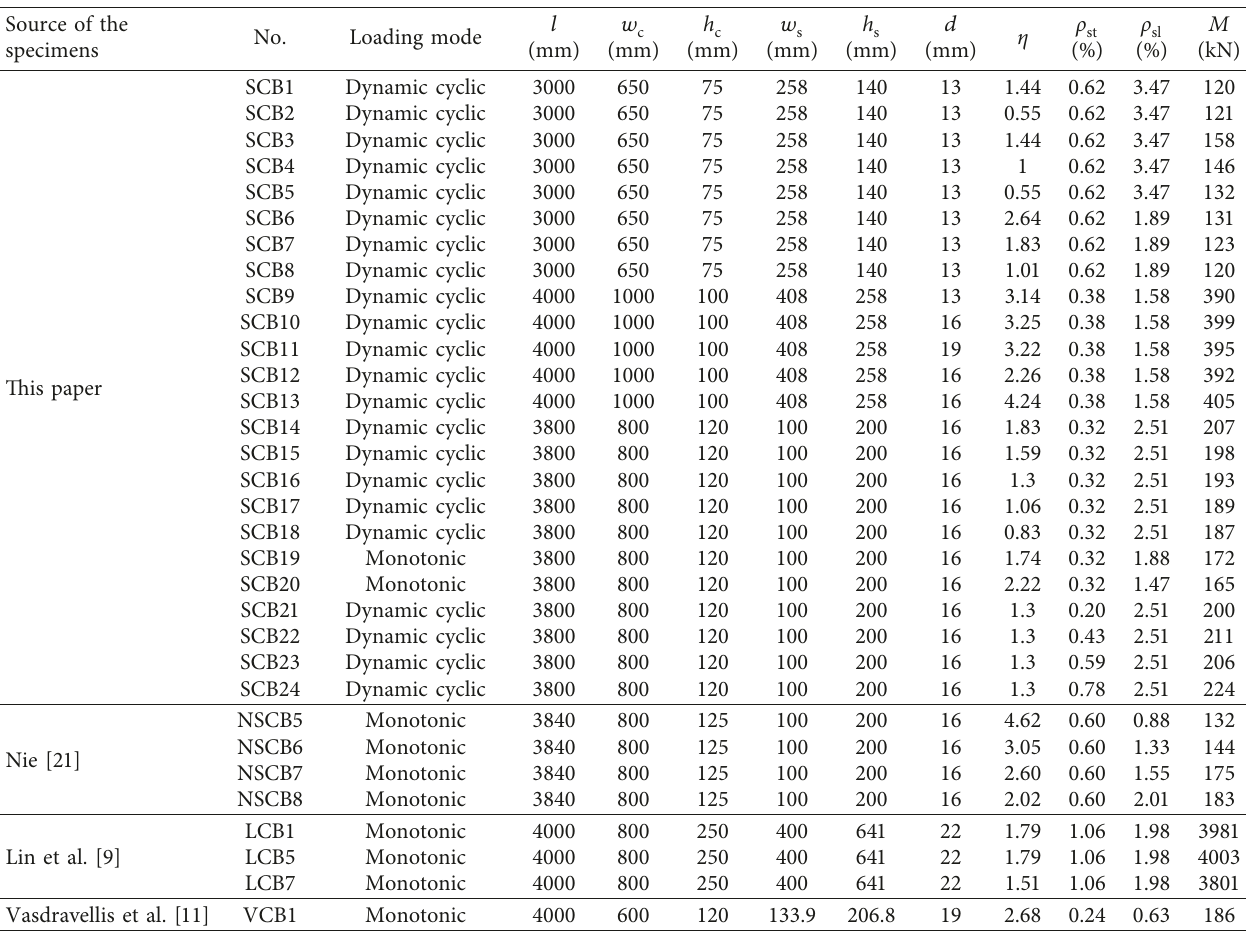
Table 1: Geometric properties and characteristics of composite